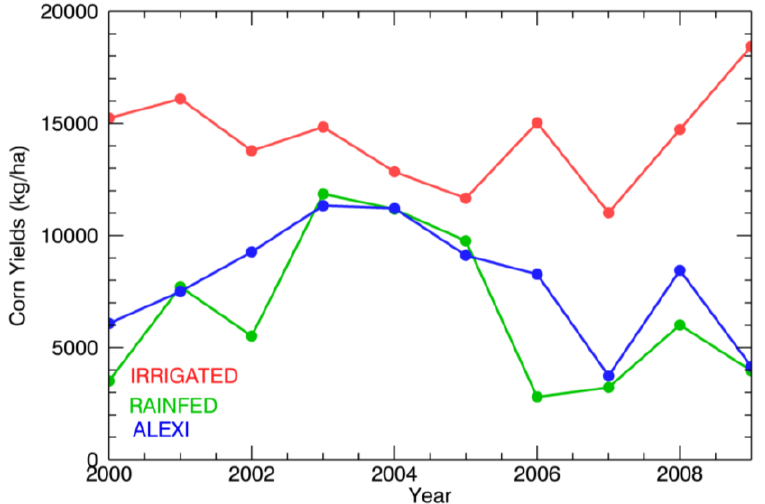
Figure 3. Comparisons of DSSAT rainfed (green), irrigated (red) and ALEXI-driven (blue) crop